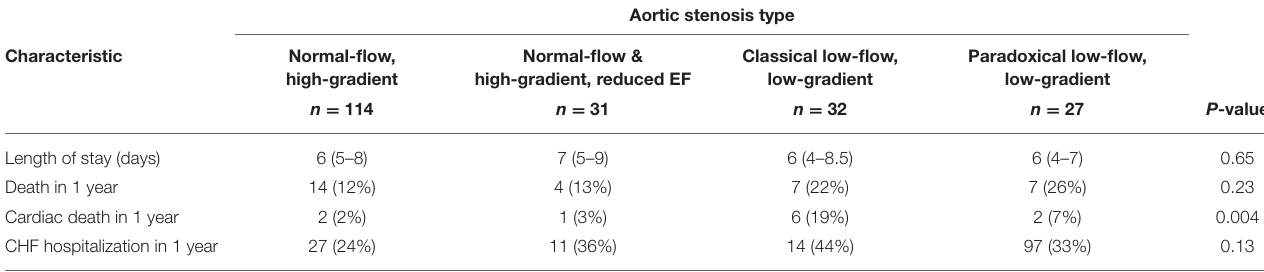
TABLE 2 | Clinical outcomes stratified by subtypes of aortic stenosis ( n = 204).